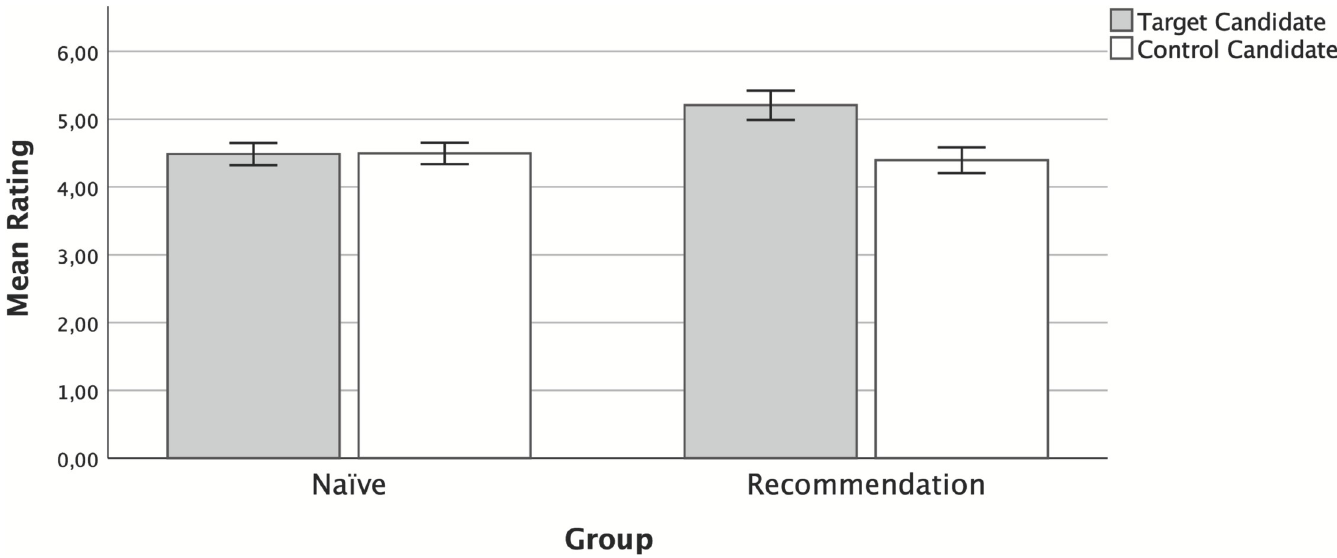
Fig 1. Mean willingness to vote for target and control candidates for each group in Experiment 1. Error bars represent 95% CI.